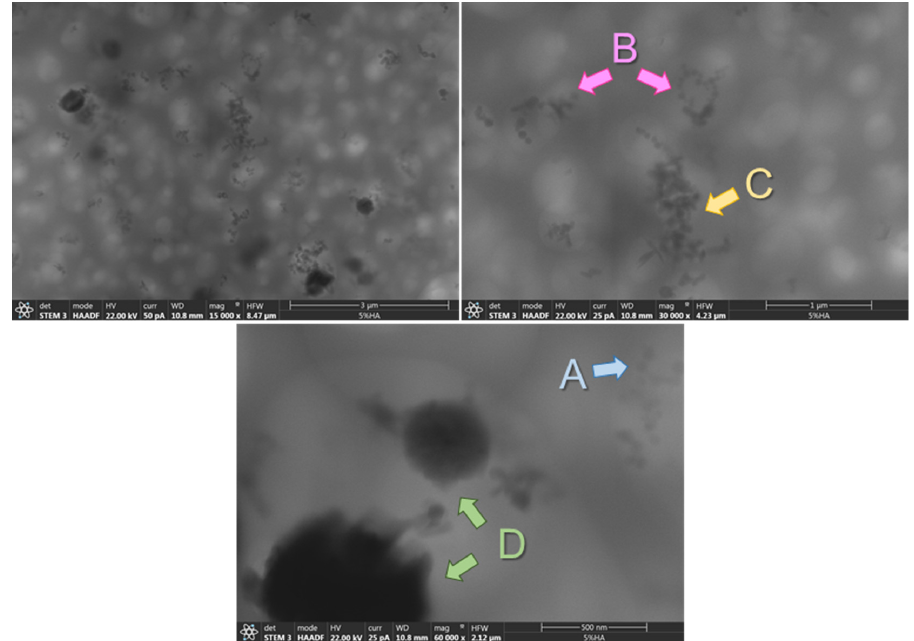
Figure 3. STEM images at different magnifications of the PSF-based composite with 5% wt of HA nanoparticles (15,000×; 30,000× and 60,000×). In every case, elemental microanalysis was carried out to obtain local information about the relative amount of HA used for the purpose of the calcium to sulfur signal ratio (Ca/S). In Figure 4, two X-ray spectra taken from one aggregate and one agglomerate, respectively, are shown. In both cases, the appearance of HA is clear if the signal coming from Ca and P are considered. Furthermore, as expected, in the case of the X-ray spectrum taken at the agglomerate (Figure 4, bottom) a higher ratio of Ca/S is observed evidencing a higher accumulation or density of HA nanoparticles.